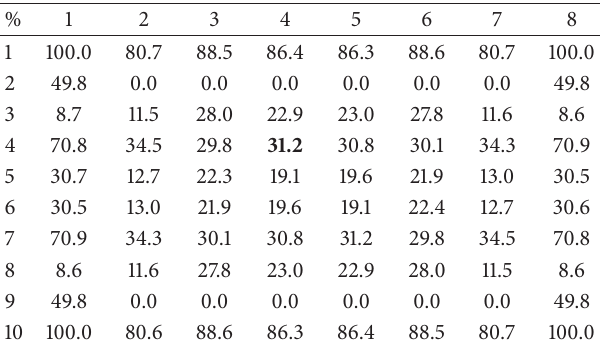
Table 1: Optimal power distribution of heaters on upper